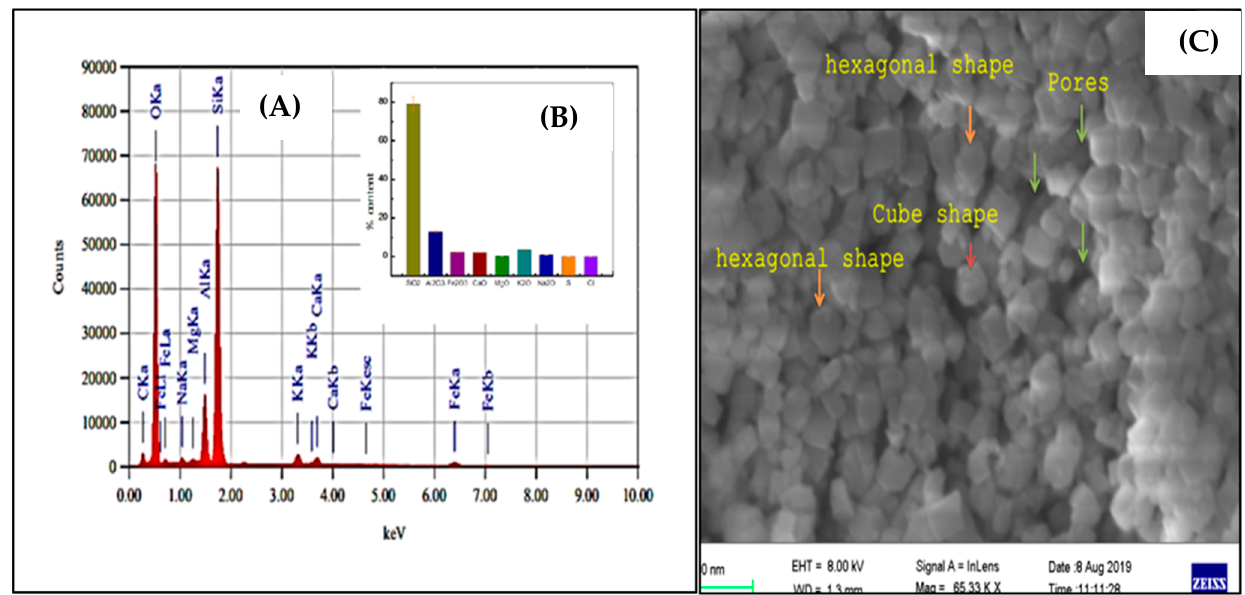
Figure 1. EDX analysis ( A , B ); the inset figure represents the XRF and the SEM ( C ) for the prepared Nano ZT.